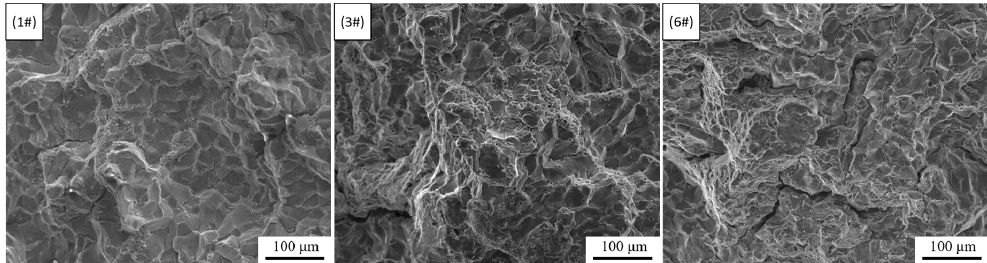
Figure 13. SEM photos of tensile fractures of 1#, 3# and 6#. (1#: no treatment; 3#: no electromagnetic stirring, adding 0.15 wt.% Sc; 6#: applying IC-AEMS, adding 0.15 wt.%